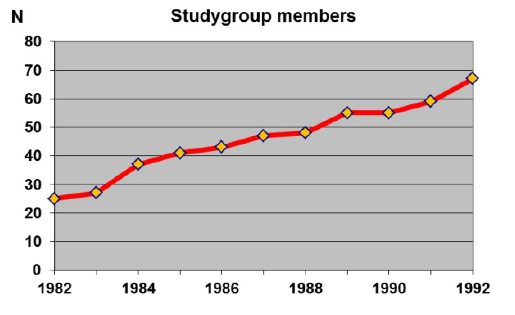
Figure 1. Number of (Full And Candidate) Members of the Study Group